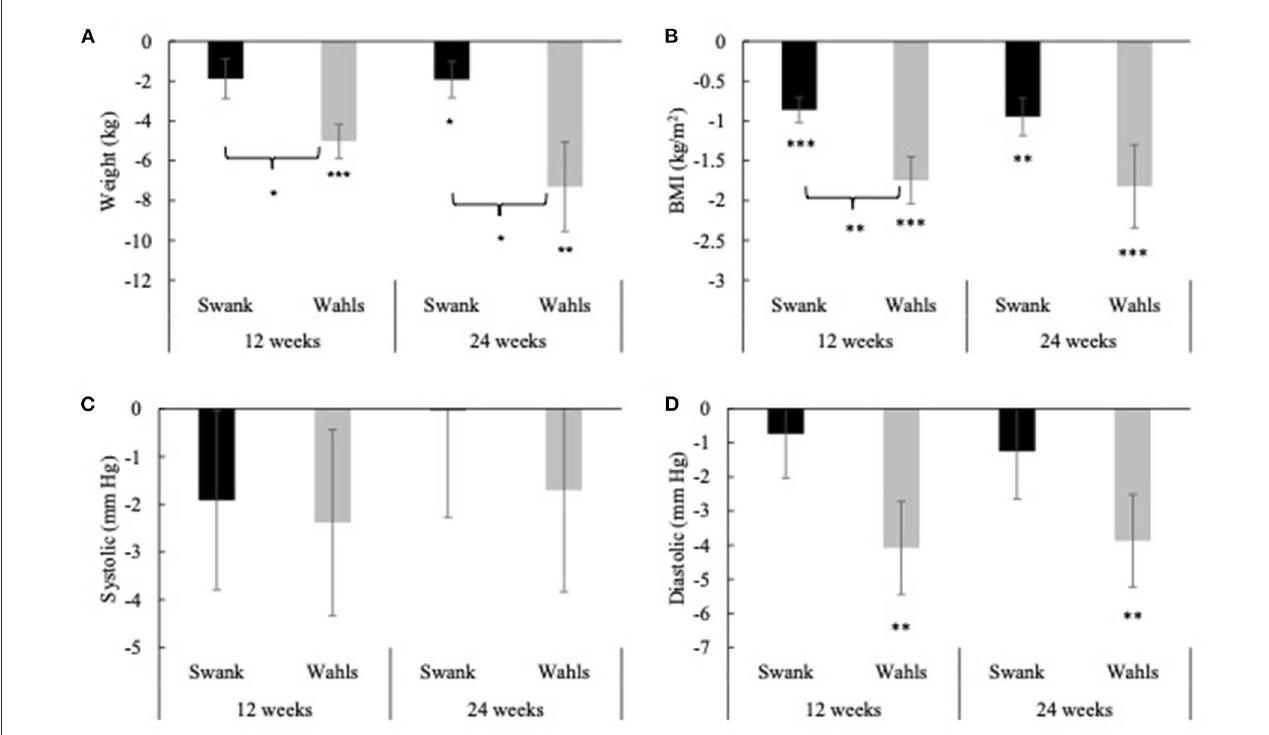
FIGURE2 Mean change from baseline for (A) weight, (B) BMI, (C) systolic blood pressure, and (D) diastolic blood pressure at 12- and 24-weeks for the Swank (black bars) and Wahls (gray bars) groups. Statistical significance was determined by generalized linear mixed models and represented by * p ≤ 0.05, ** p ≤ 0.01, and *** p ≤